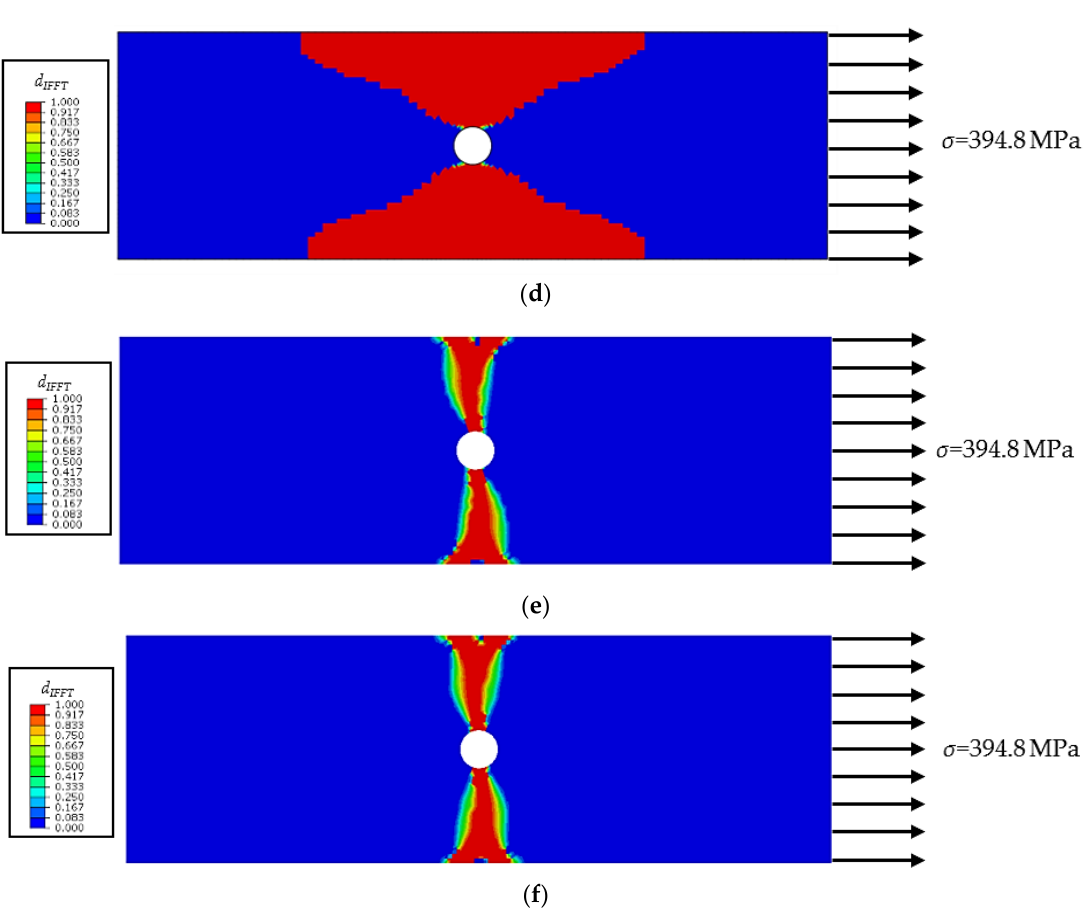
Figure 11. Progressive failure process of the CFRP laminate under tension. ( a ) IFFT initiates in a 90° ply; ( b ) FFT initiates in a 0° ply; ( c ) Damage variable d FFT in a 0° ply; ( d ) Damage variable d IFFT in a 90° ply; ( e ) Damage variable d IFFT in a 45° ply; ( f ) Damage variable d IFFT in a −45° ply.